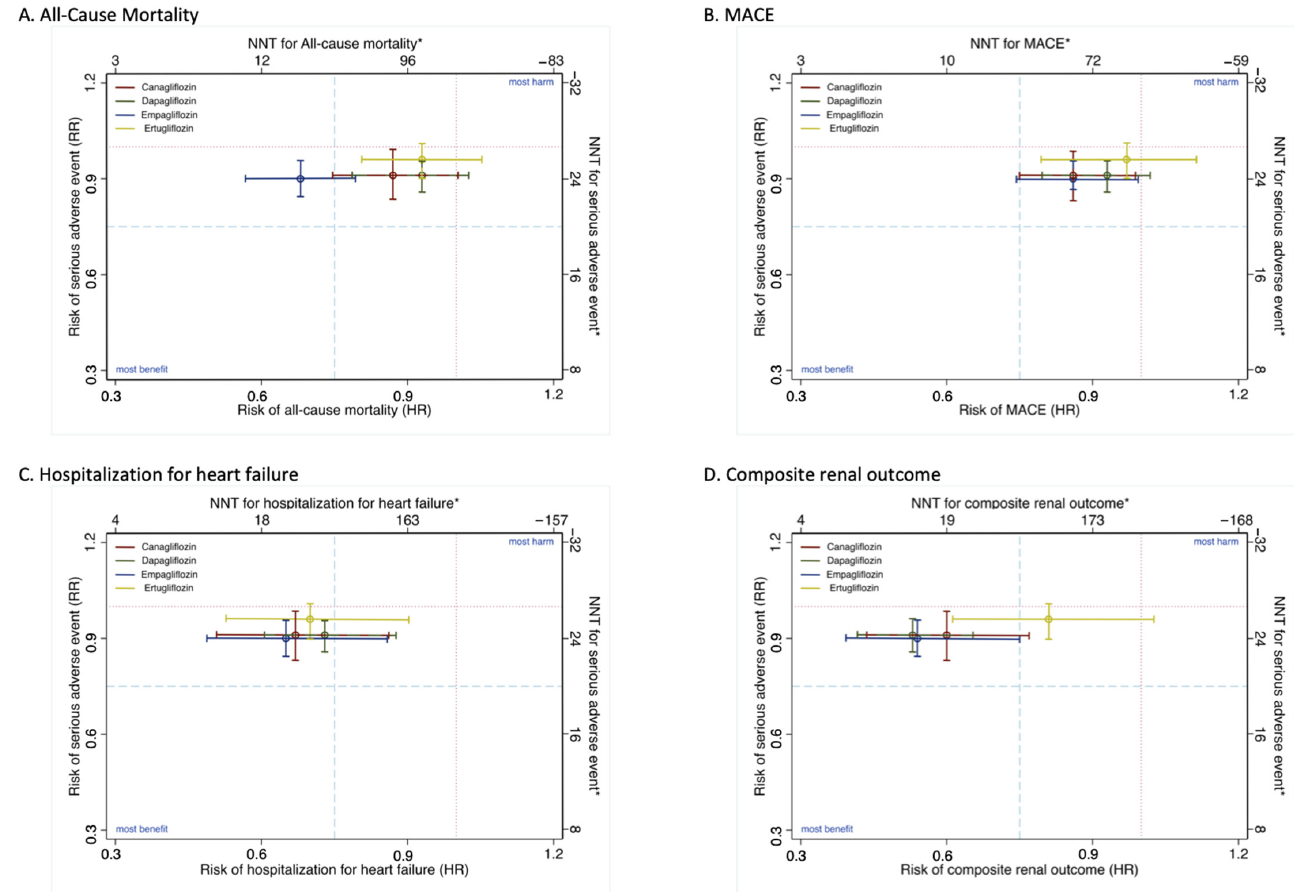
Figure 5. Comprehensive scatterplot for the efficacy of canagliflozin, dapagliflozin, empagliflozin and ertugliflozin vs. placebo for main outcomes (x-axis) and serious adverse events (y-axis). ( A ) All-cause mortality; ( B ) MACE; ( C ) Hospitalization for heart failure and ( D ) Composite Renal. Treatments lying on the lower left-hand side quarter are the most beneficial. Abbreviations: RR: relative risk; HR: hazard ratio; NNT: number needed to treat (calculated as 1/Absolute risk reduction (ARR), with ARR = exposed incidence minus non-exposed incidence). * NNTs have been estimated from the pooled NNTs for each outcome and serious adverse event from Figures 3 and 4.